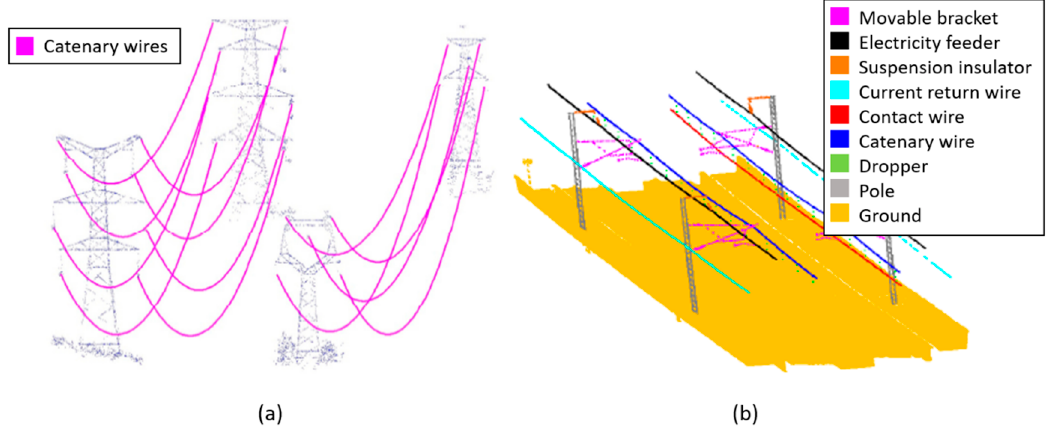
Figure 10. Power line. ( a ) Guo et al. [159] classified ALS point clouds into power line cables using a JointBoost classifier and then used RANSAC to reconstruct the cables’ shapes. ( b ) Jung et al. [161] grouped points in MLS data using SVM classification results as inputs for the multi-range CRF model.